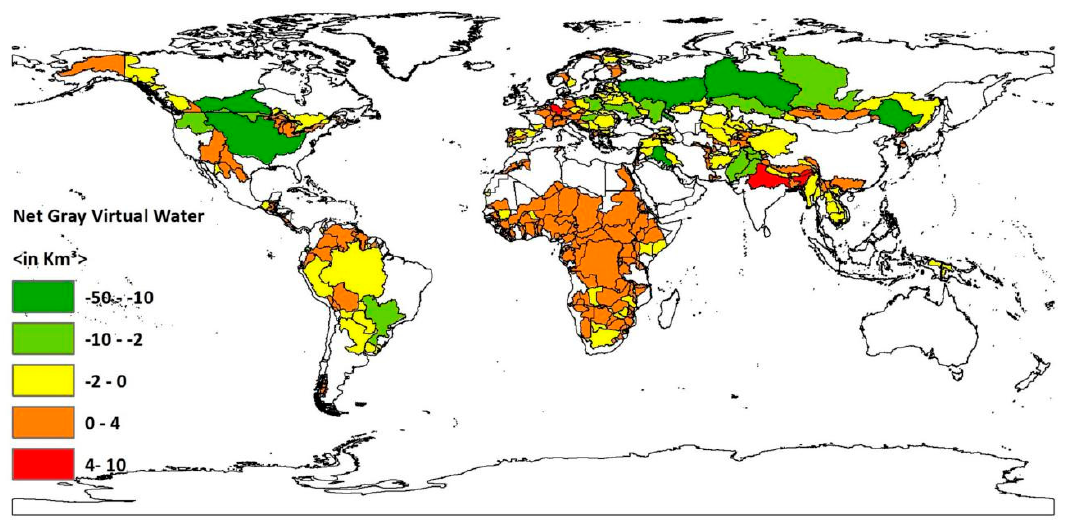
Figure 5. Net gray virtual water balance for global transboundary river basins’ country-basin units. Period: 1996–2005. This map was generated with ArcGIS 10.2 for desktop from Environmental Systems Research Institute (ESRI), Redlands, CA, USA [28].